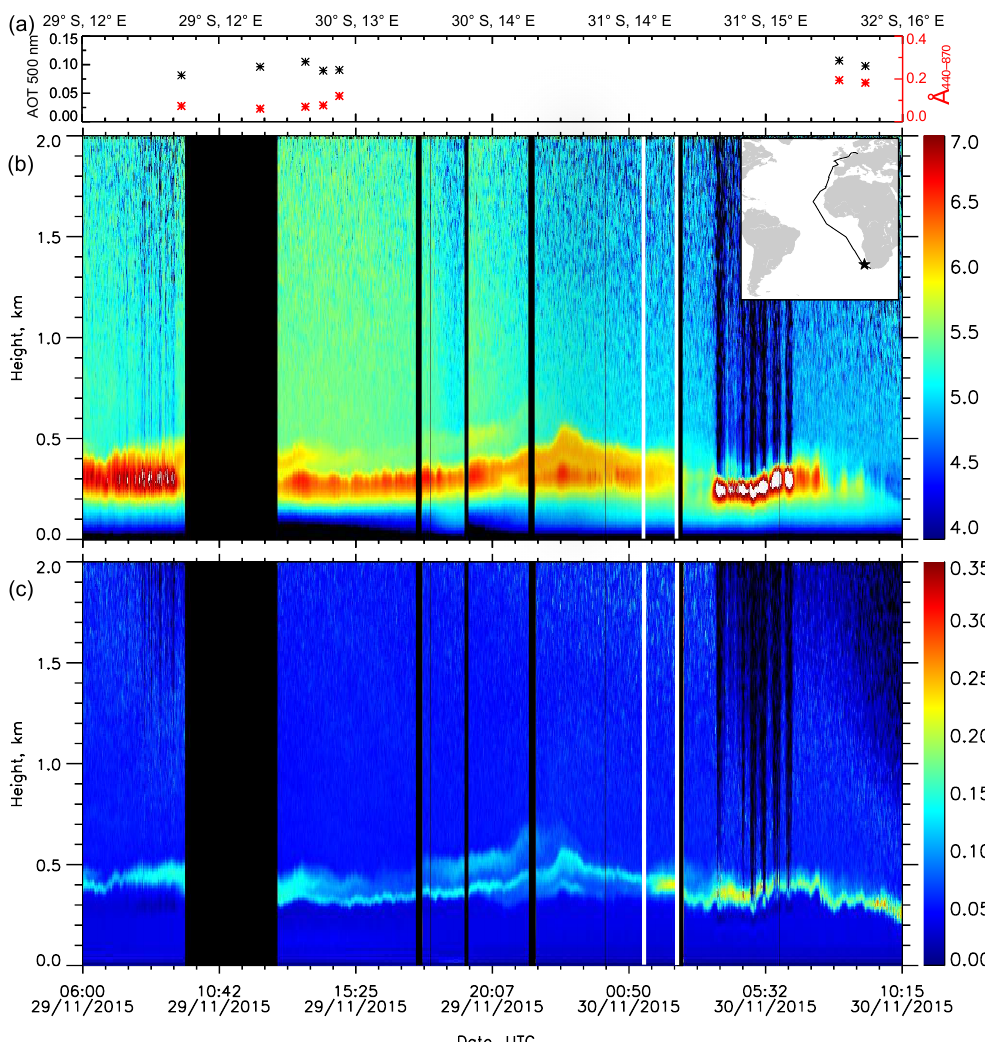
Figure 4. Marine conditions during PS95: time series of the Microtops sun-photometer-derived AOT at 500 and 440/870nm Ångström exponent (a) , 1064nm range-corrected signal (b) , and 532nm volume depolarisation ratio (c) . Vertical white lines indicate the signal- averaging period for profiles shown in Fig. 5. The black star in the cruise map shows the location of RV Polarstern during this period.